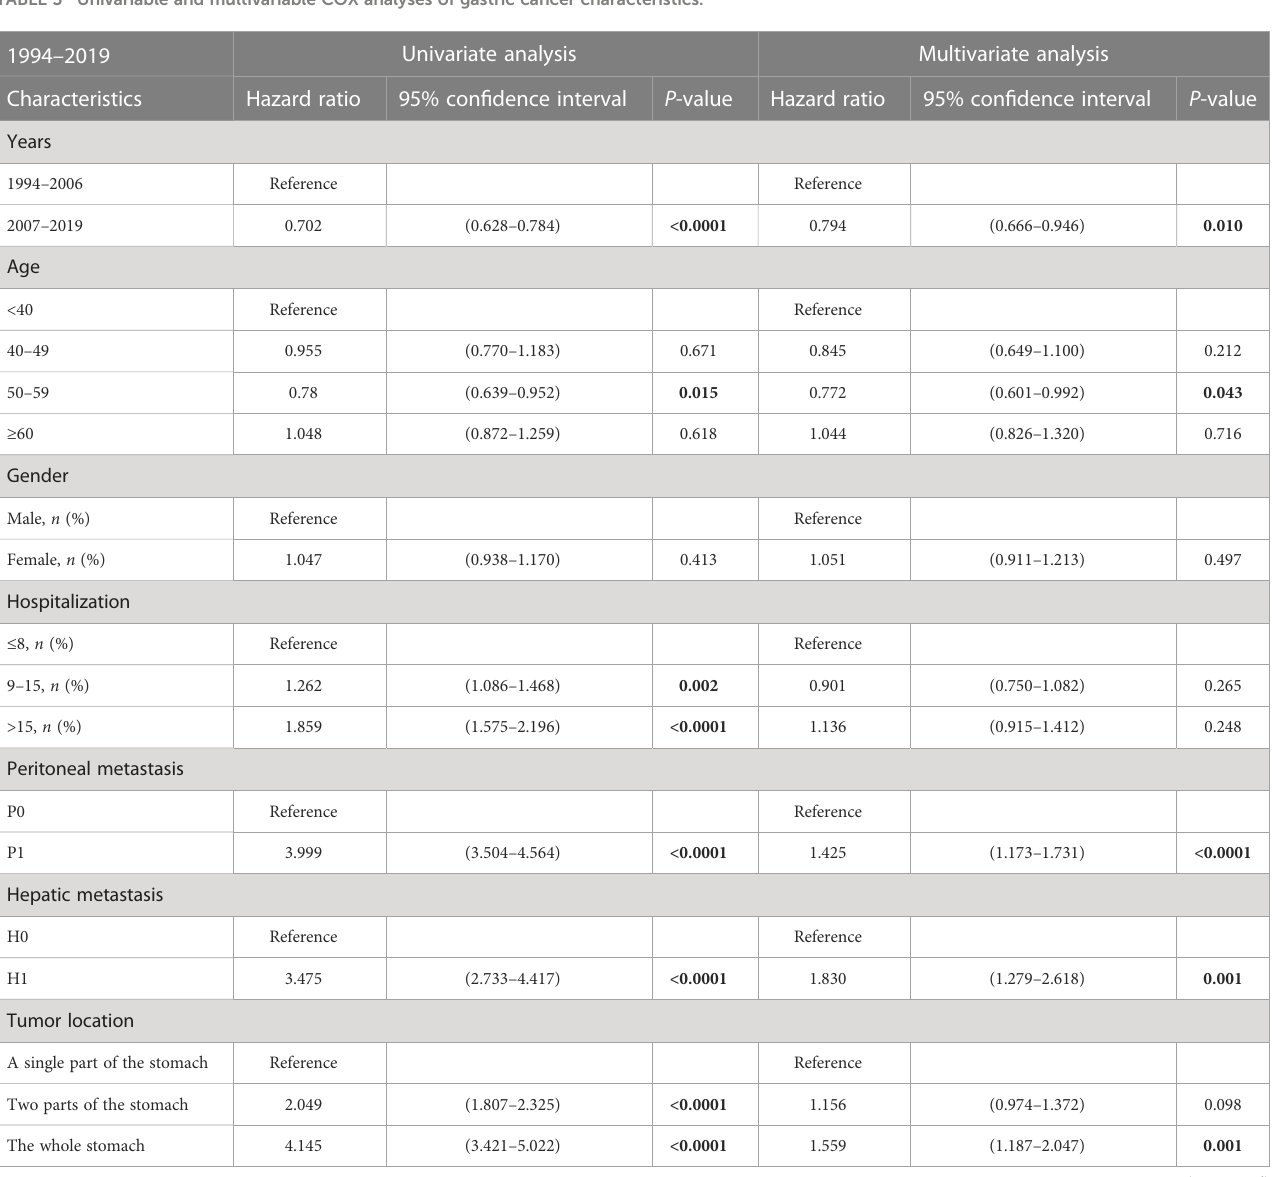
TABLE 3 Univariable and multivariable COX analyses of gastric cancer